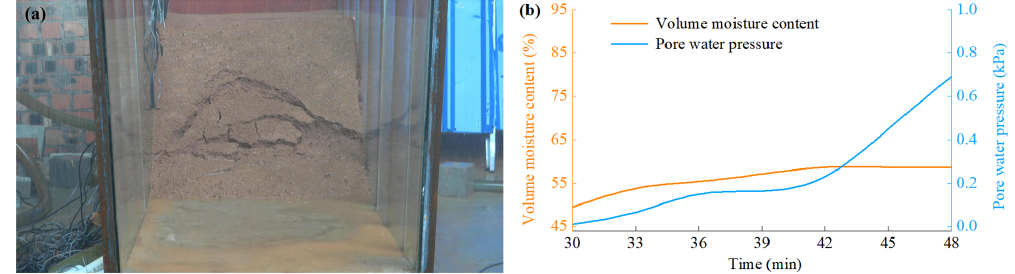
Figure 21. Typical phenomenon and result with an initial dry density of 1.20gcm − 3 . (a) Slope failure. (b) Results of sensor no. 7 closest to sliding